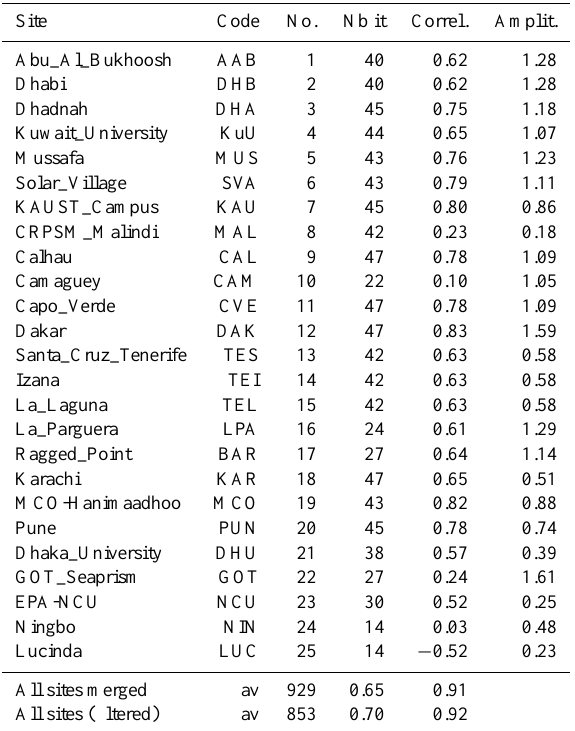
Table 4. Correlation between IASI and CALIOP altitude (column 5) and amplitude (last column) over oceanic regions. Each site is identified by its name (first column), its three-digit code (second column), and identification number (third column). The fourth col- umn gives the number of items in the statistics. The two last lines give the overall statistics: first line – all sites merged; second line – without three sites (Malindi, Ningbo, Lucinda), see text.